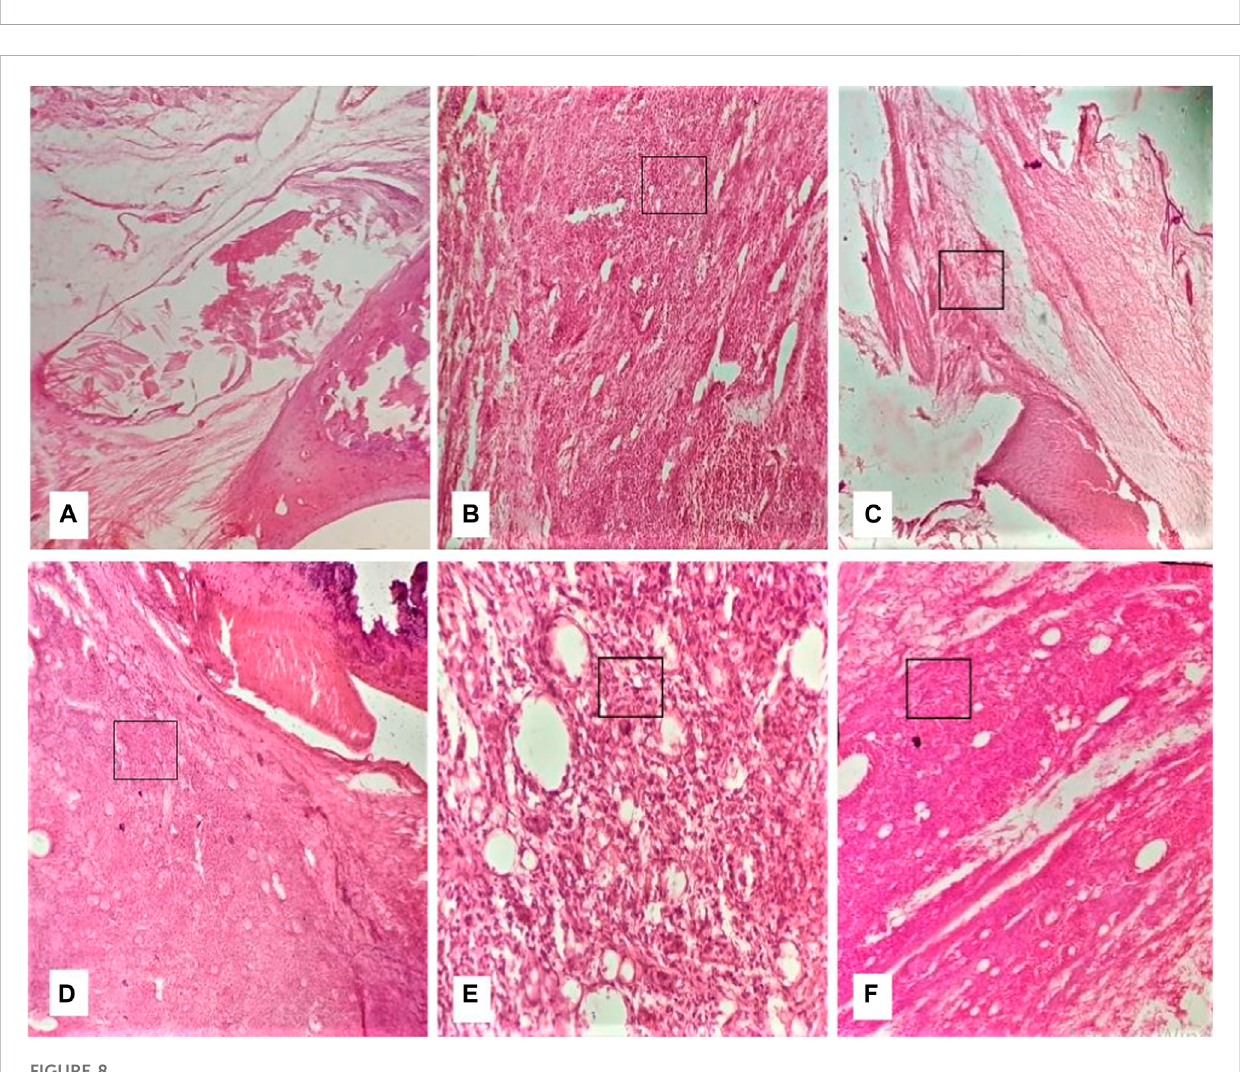
Effectof Quercusleucotrichophora onhistopathologyofCFA-inducedarthriticrats. (A) normalgroup, (B) diseasedgroup, (C) standardgroup, (D – F) QLME at 150, 300, and 600 mg/kg, respectively. shows in fl